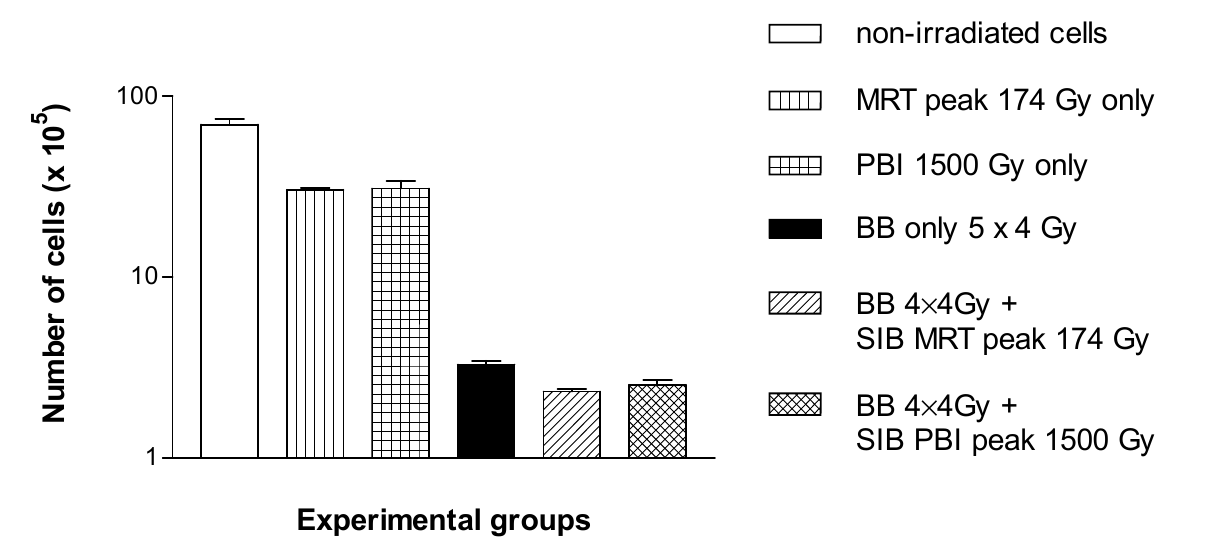
Figure 4. Cell counts after the late microbeam SIB. A significantly increased cell destruction, com- pared to the non-irradiated controls, was seen in all irradiated groups. The differences in the cell destruction were also statistically significant between the low dose rate and the high dose rate irra- diation groups but not between the two high dose rate irradiation groups.